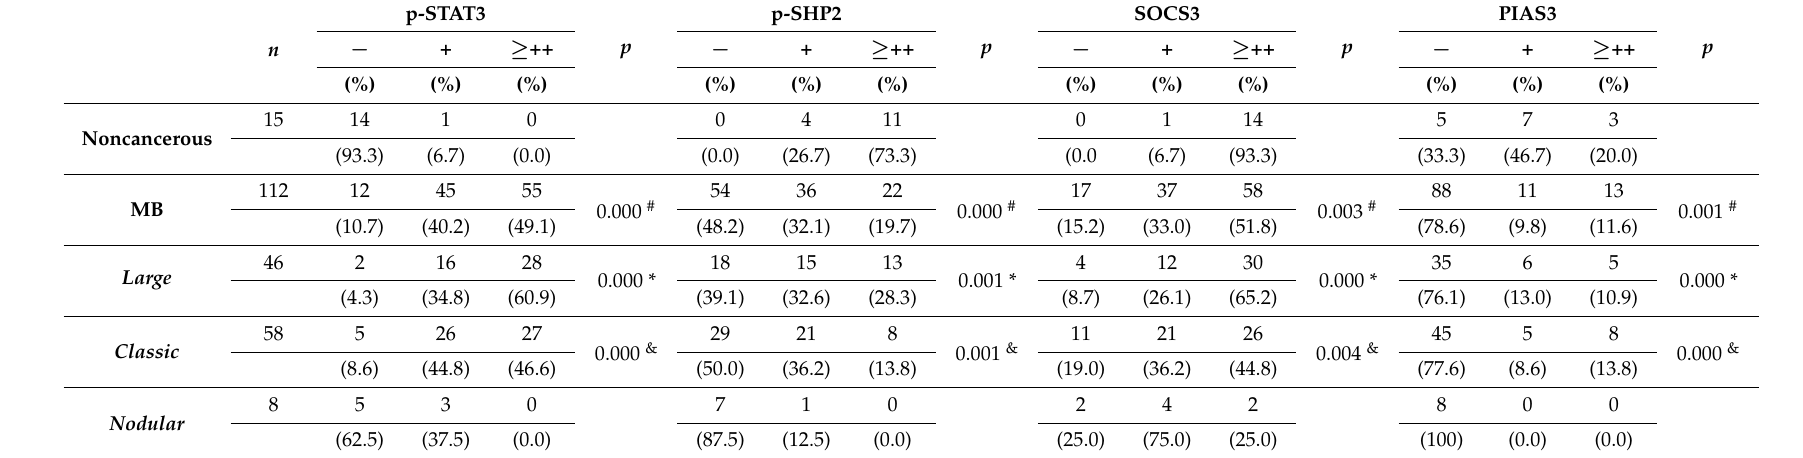
Table 2. p-STAT3, p-SHP2, SCOs3 and PIAS3 expression in three subtypes of medulloblastomas and cerebellum